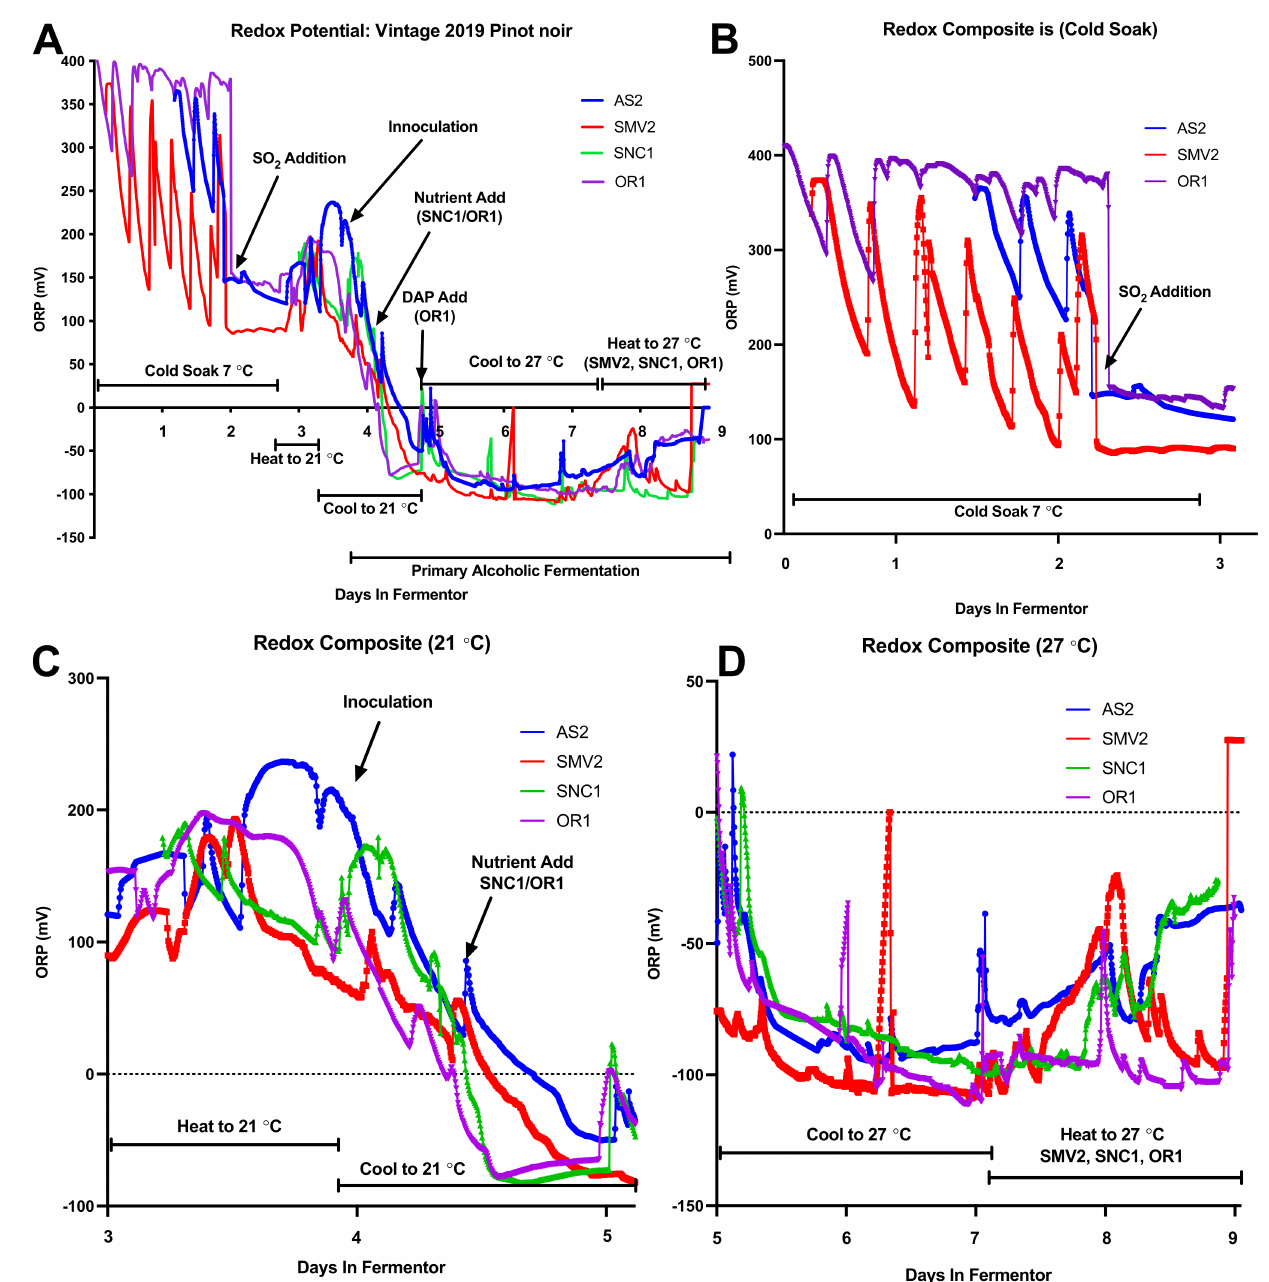
Figure 3. Each data point represents a 5 min interval. ( A ) Composite graph with the mean of all ORP measurements